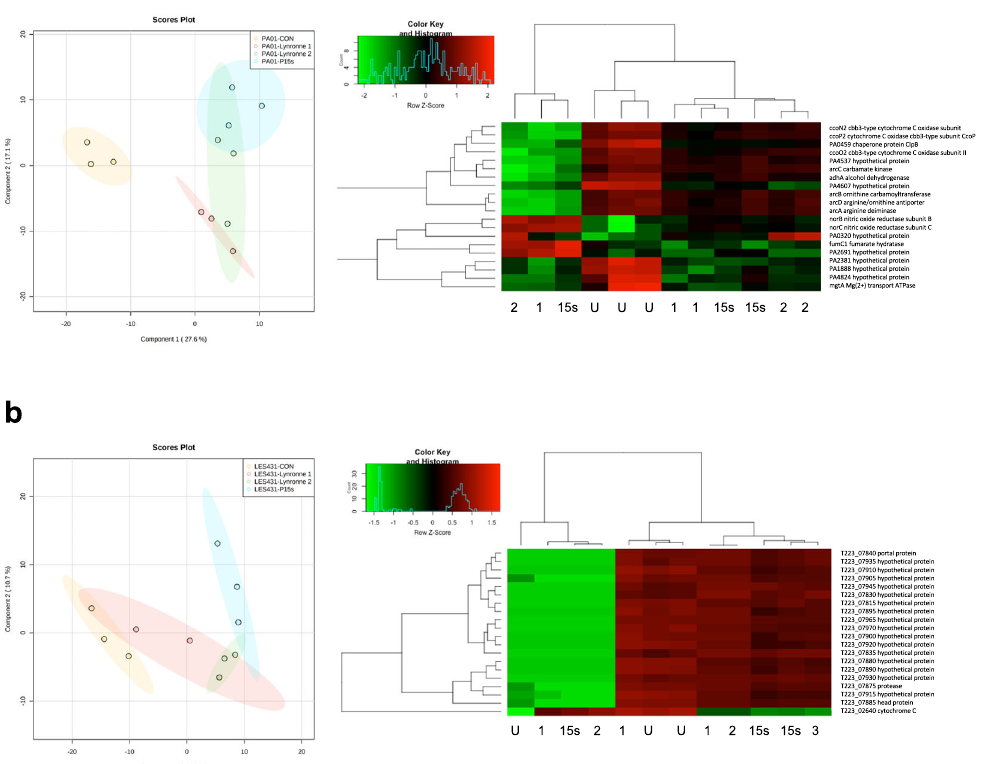
Fig. 5 Peptide-induced transcriptional changes in PAO1 and LES431 cells. Partial least squares discriminant analysis (PLS-DA) and hierarchical cluster analysis (HCA): heatmap based on the 20 top-variable genes, highlighting differences between untreated and peptides Lynronne 1, Lynronne 2 and P15s sample groups for P. aeruginosa strain, ( a ) PAO1 and ( b )